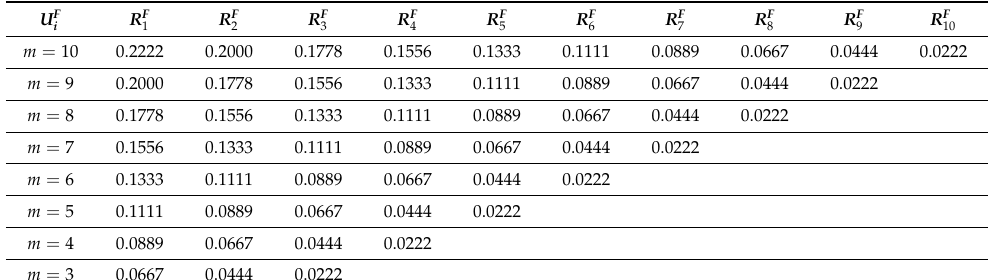
Table 5. The constant values of the significance of options/alternatives based on the number of options/alternatives.